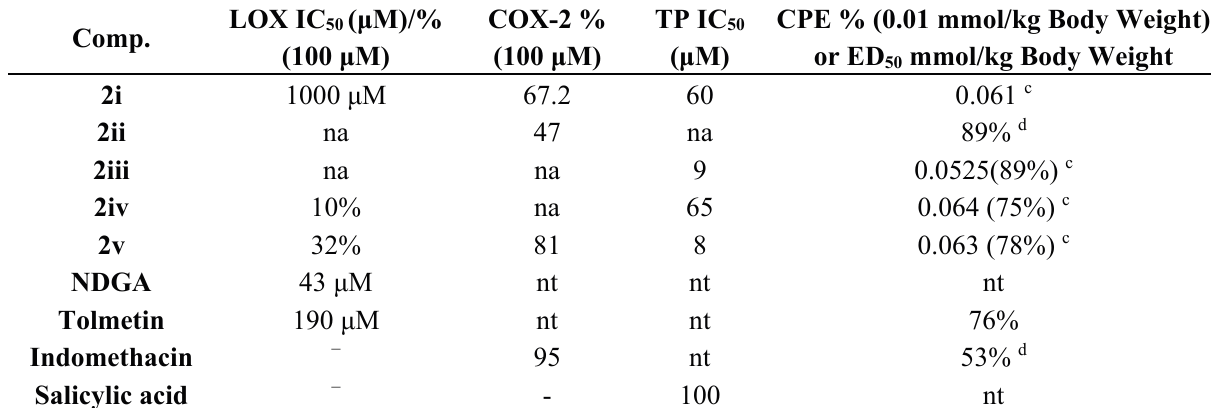
Table 7. Inhibition of soybean lipoxygenase (LOX IC 50 μΜ or % at 100 μ M); percent inhibition of cycloxygenase-2 (COX-2 % at 100 μΜ ); inhibition of trypsin (TP IC 50 μΜ ); inhibition of rat paw edema induced by carrageenan (CPE %).